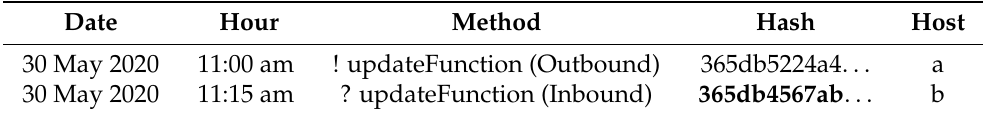
Table 3. Bad entries in the log of the client